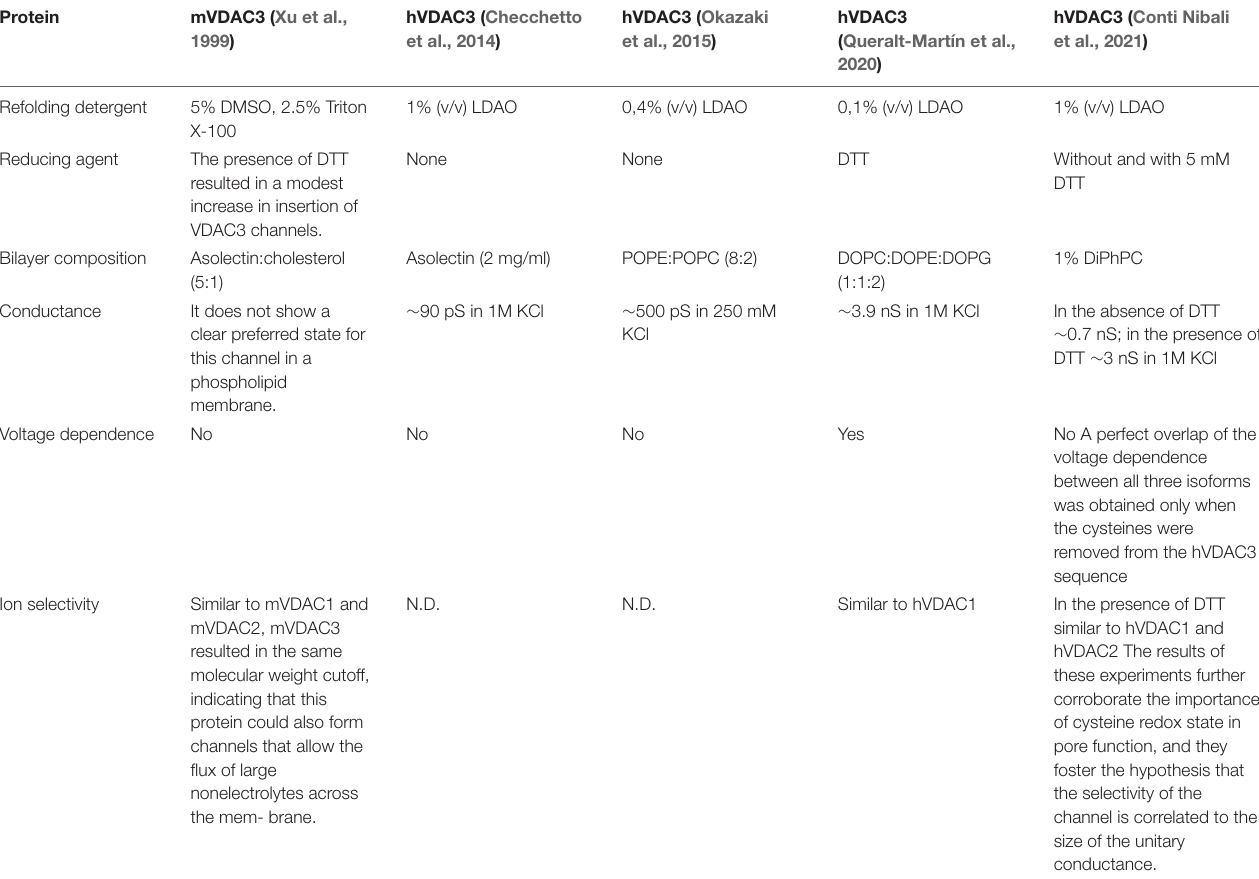
TABLE 1 | Summary of information on VDAC3 channel activity.